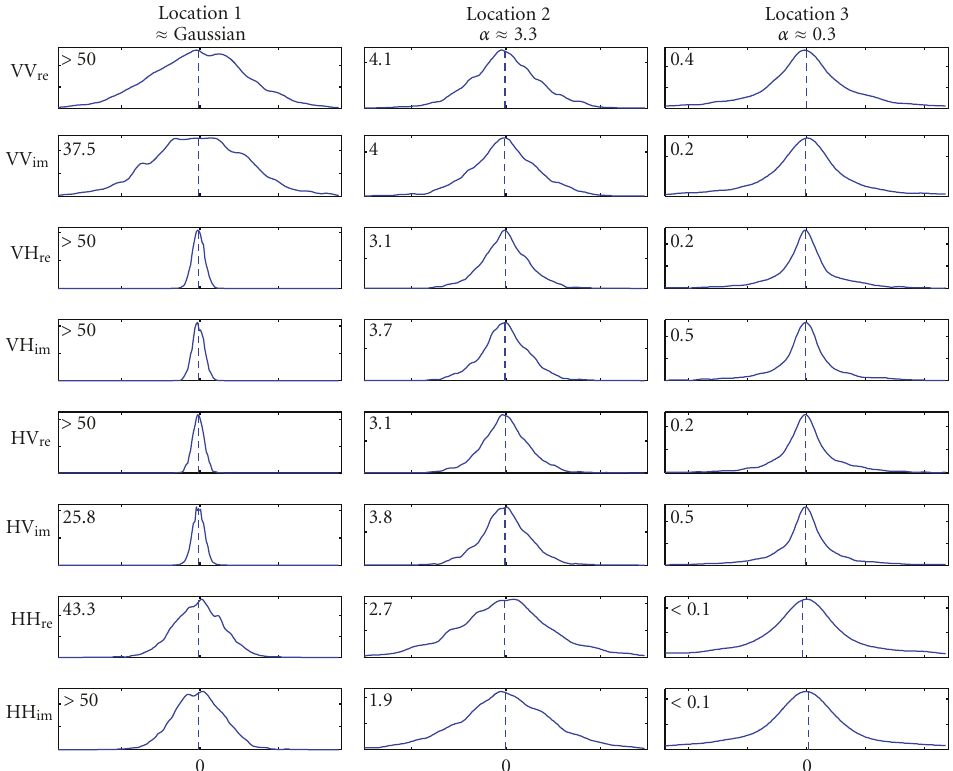
Figure 3: Real data observations: non-Gaussian, global symmetric shape, polarimetric width variations, zero-mean, and individual and overall shape α estimates noted. Actual locations represent water, forest, and urban